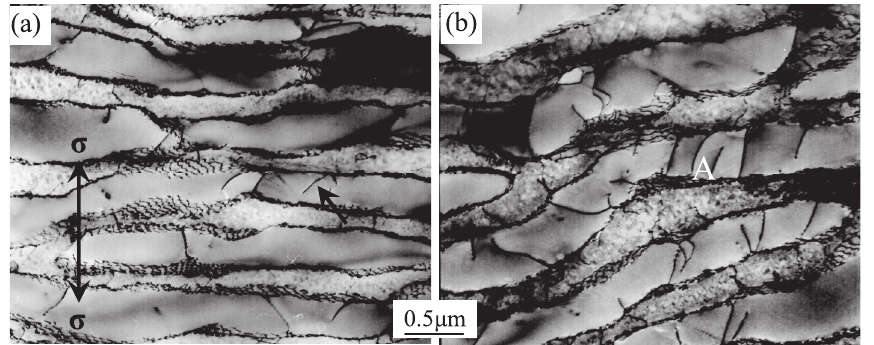
Fig. 7: Microstructure of alloy after being crept for 92 h up to fracture at 1040 °C/137 MPa. (a) Twist of the rafted g′ phase, (b) alternate slipping of